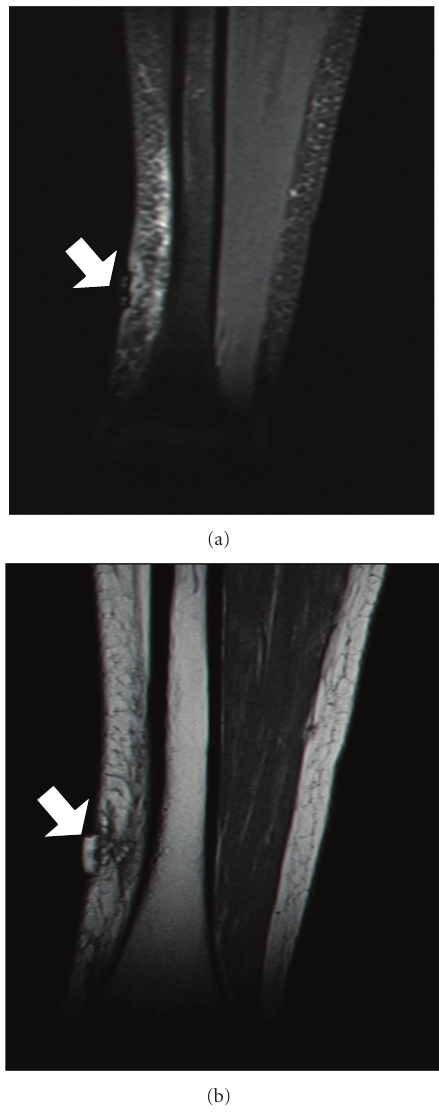
Figure 2: (a) MRI-T1 tirm and (b) MRI-T1. Coronal slices of the distal part of shin with cutaneous tag. MRI findings were edema in subcutaneous fat medial to tibial bone with thickening of subcutaneous septations and unclear boundaries, without involve- ment of bone cortex or marrow. T2-weighed images did not add information and are not